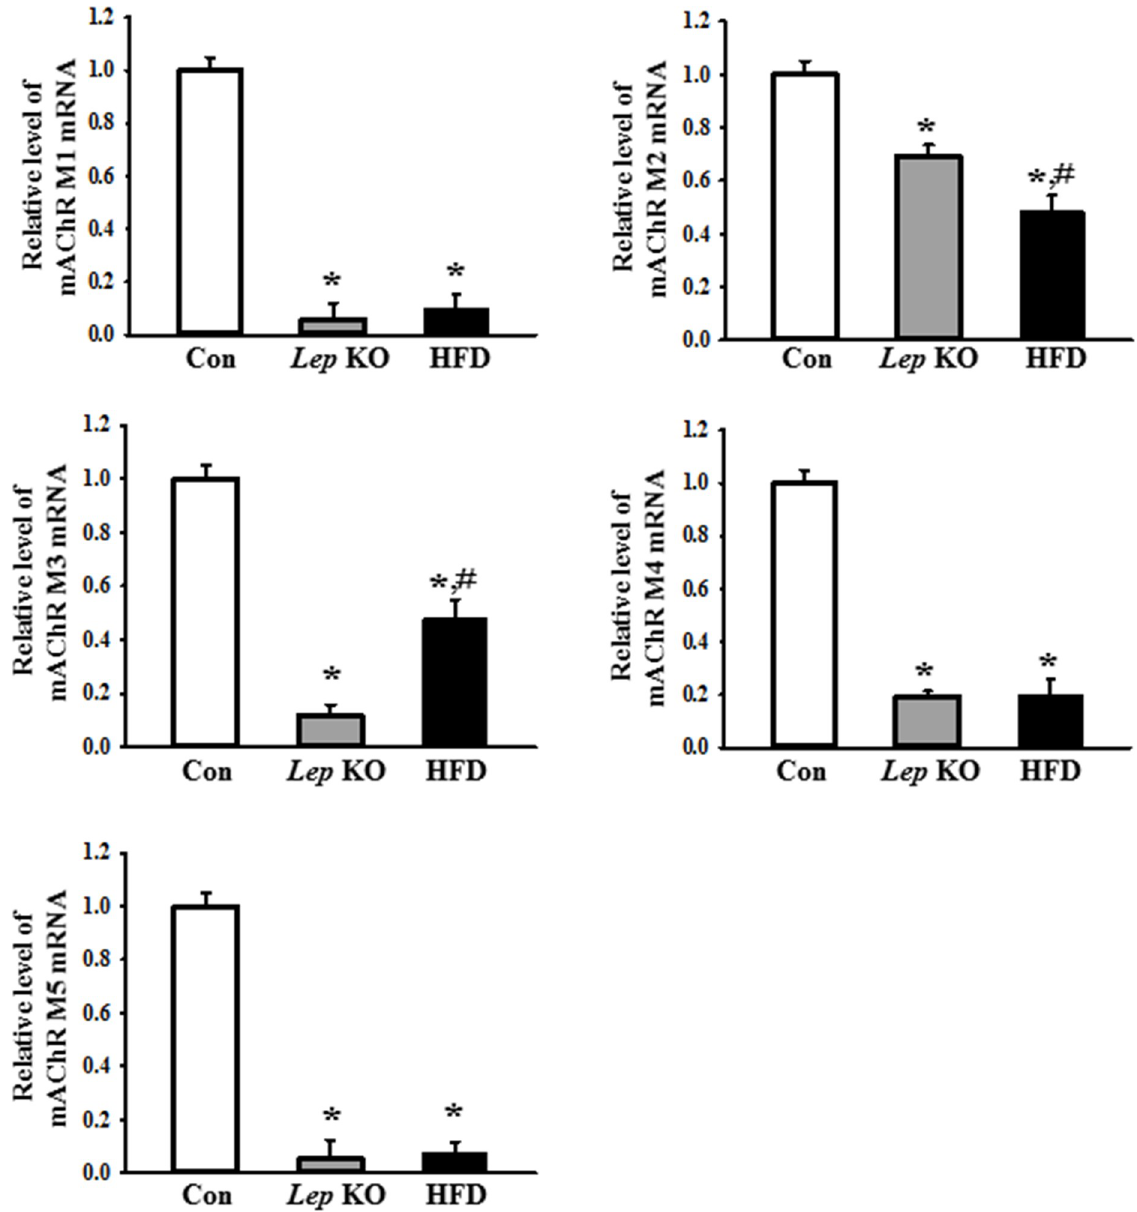
Fig 7. Expression of mAChR M1, M2, M3, M4, and M5 mRNA in the mid colon. The levels of the five mAChRs mRNA in the total mRNA of the mid colon were measured by RT-qPCR using the specific primers. The mRNA levels of these genes were calculated based on the intensity of β -actin as an endogenous control. Three to five mices per group were used to prepare the total RNA. The RT-qPCR analyses were assayed in duplicate for each sample. The data are reported as the mean ± SD. � indicates p < 0.05 compared to the Con group. Abbreviations: Con, Control group; Lep KO, Leptin knockout mice; HFD, High fat diet; mAChR, muscarinic acetylcholine